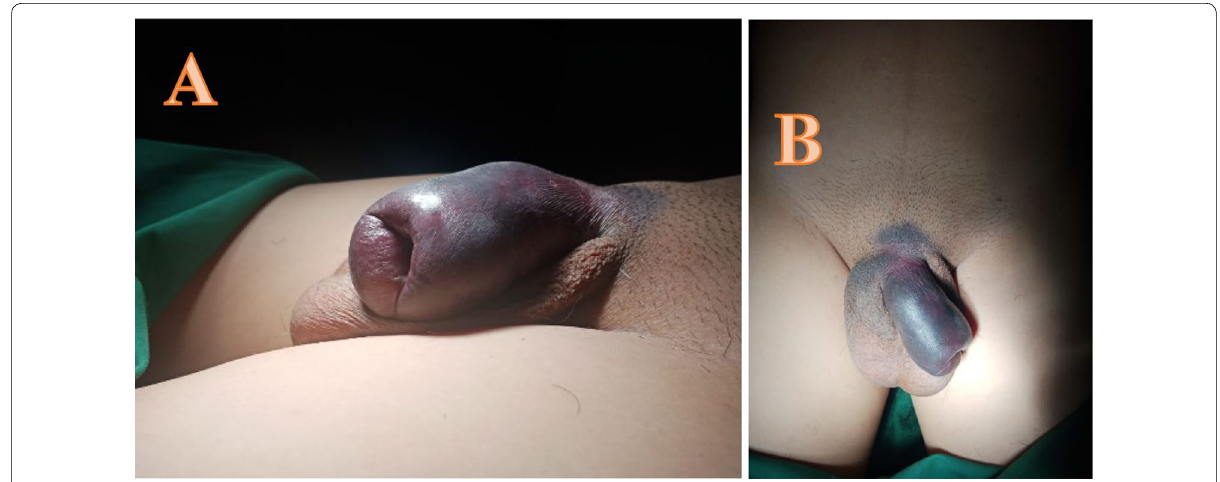
Fig. 1 a Gross appearance of the penis. b The penis was angulated to the left with edema and local hematoma